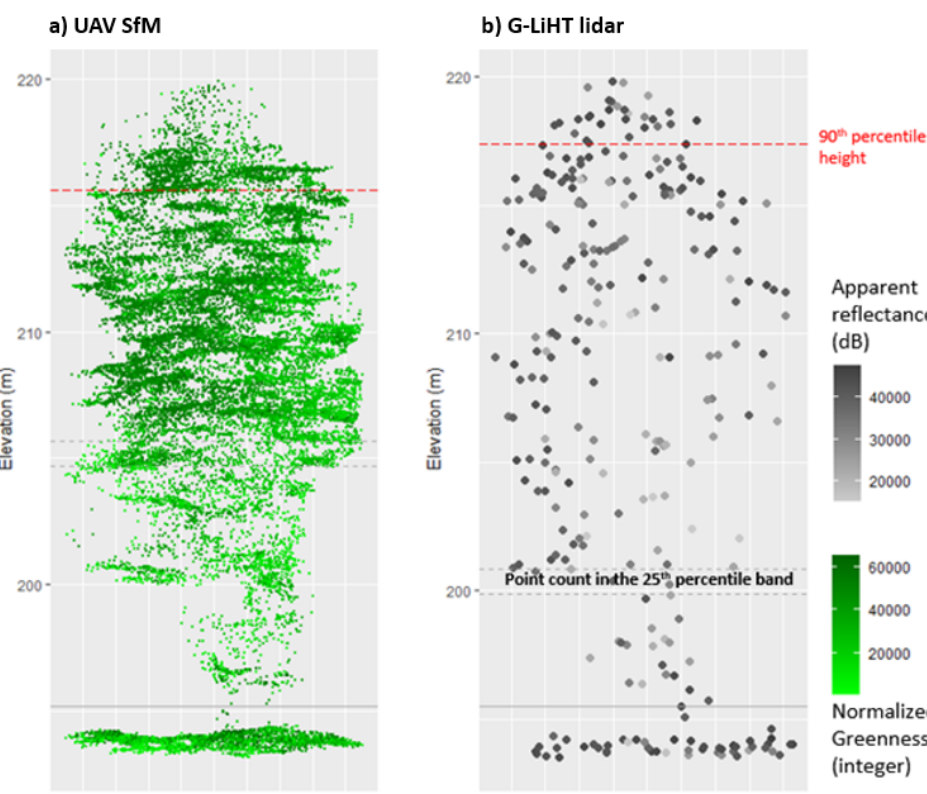
Figure 3. Cross-sectional view of point clouds from the same crown with example structural metrics where ( a ) is UAV SfM and ( b ) is G-LiHT lidar. Points below the solid grey line are understory vegetation removed prior to analysis. Table 2. Structural features extracted from UAV SfM. “[color]” notation indicates that each variable was constructed from each color (red, green, and blue).